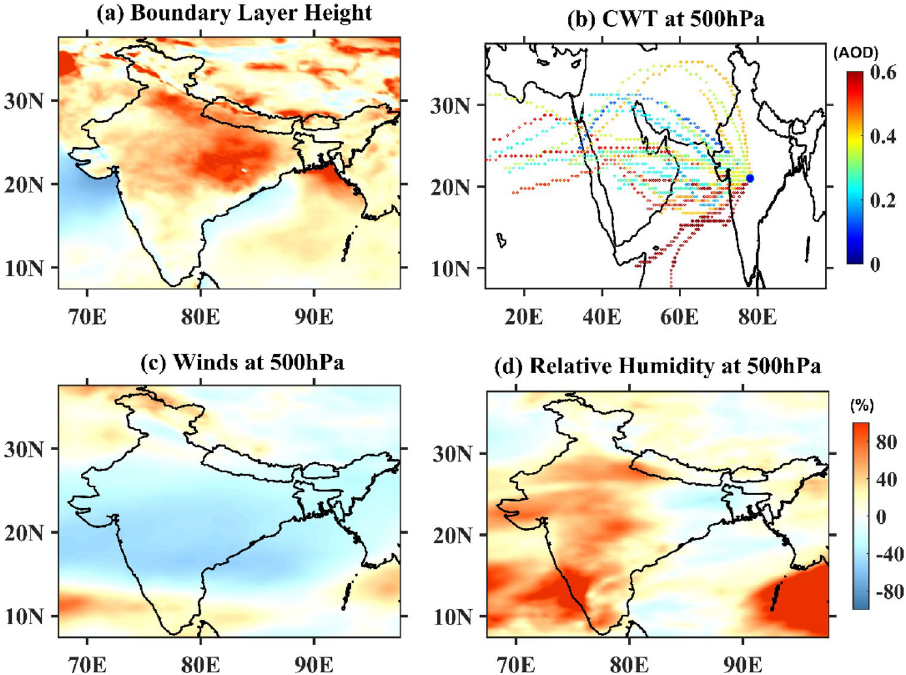
Figure 6. Percentage difference in the ( a ) BLH, ( c ) wind speed at 500 hPa, and ( d ) RH at 500 hPa observed between the PLD and DLD periods based on WRF-Chem simulations for India and the adjacent regions. ( b ) Concentration weighted trajectory (CWT) map of the AOD for Central India during the DLD period (March 25–April 20, 2020). The blue dot denotes the center of central India. The figures are plotted using GrADS V2.2.1 software (http:// cola. gmu. edu/